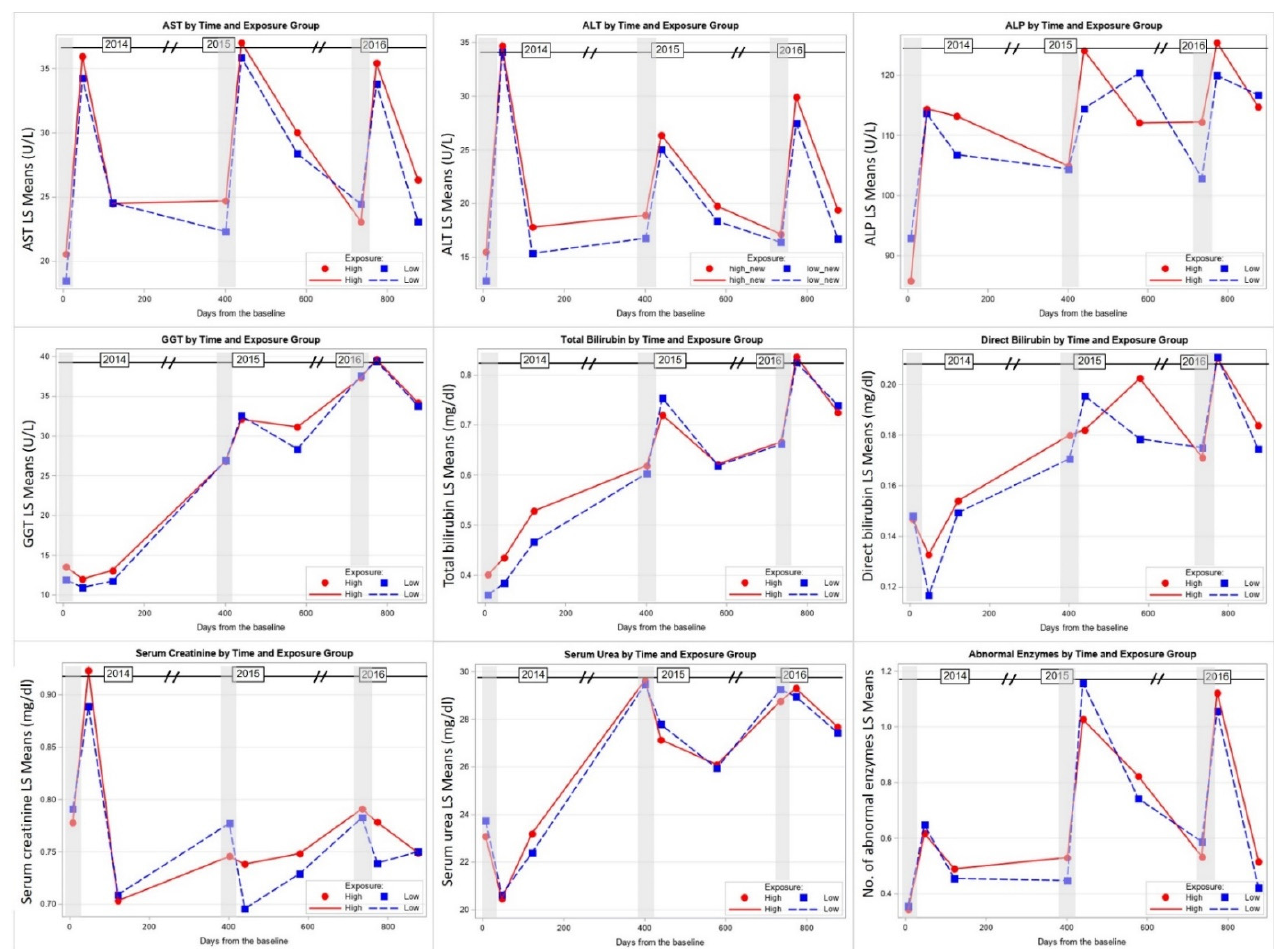
Figure 4. Least squares mean liver and kidney function measures of the study participants across the 3 years of study stratified by the high and low CPF exposure group. Shaded areas indicate the time of CPF application.